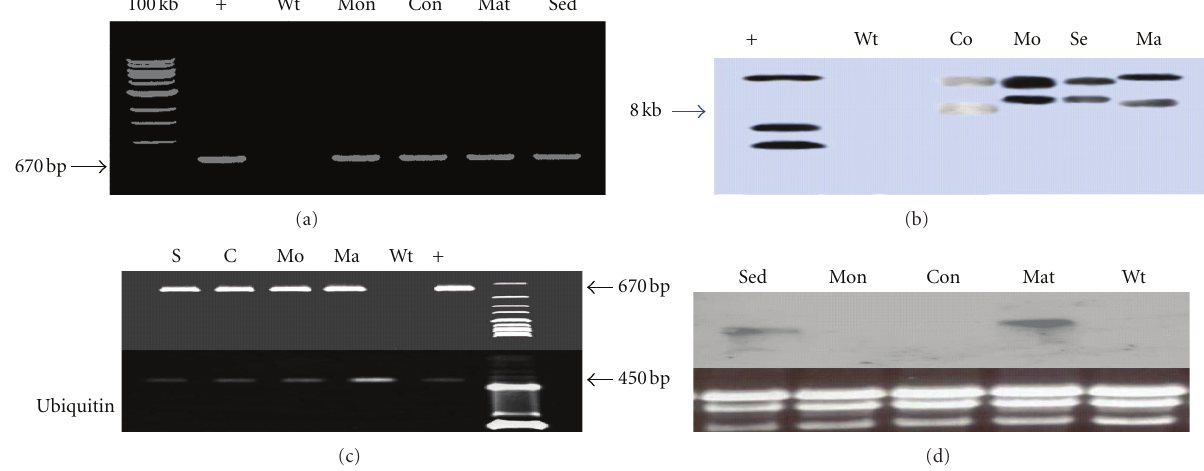
Figure 3: Molecular analysis confirming the integration and transcription of HVA1 transgene in plants. (a) PCR results of T3 transgenic plants. The expected band size is 670bp; (b) Southern blot hybridization showing integration of HVA1 gene digested with BamH1. The results indicate that there are two copies of transgene in all varieties. (c) RT-PCR of HVA1 expression for T2 transgenic plants. Like in PCR, here the expected band size is 670 bp for HVA1 . Below the RT-PCR is the cDNA loading control showing the expression of ubiquitin with the expected band size of 450 bp. (d) Northern blot analysis also confirmed the transcription of HVA1 gene in Sedona and Matterhorn. Wt: wild type shows no transgene integration; C. RNA transcription analysis of HVA1 gene in T3 transgenic plants. Mat: “Matterhorn” and Sed: “Sedona” showed some expression. The remaining lanes, Wt: wild type, Mon: “Montcalm” and Con: “Condor” showed no transcriptions.